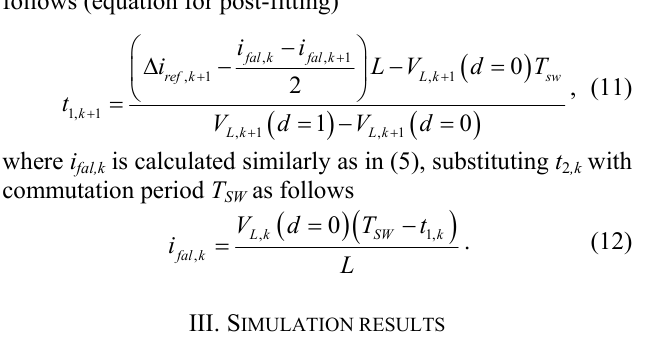
at transition between different voltage levels.